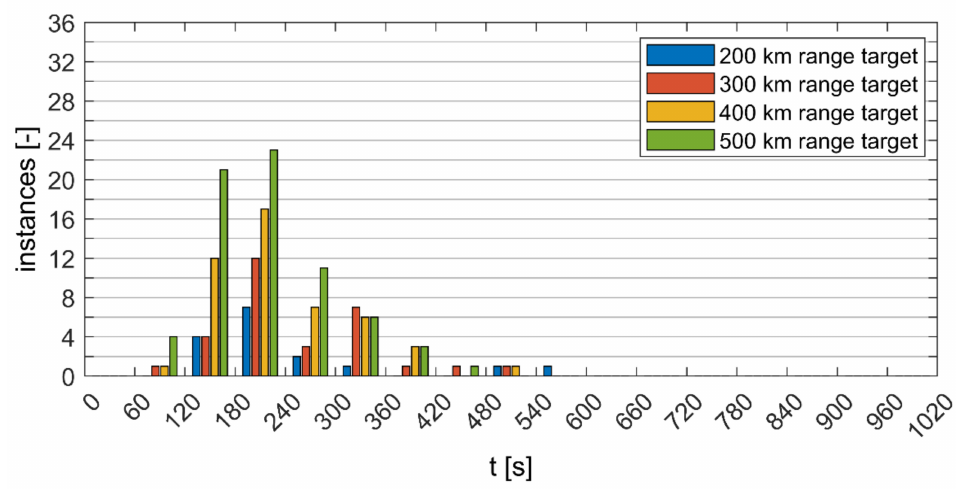
Figure A6. REX engagement instances binned by engagement time for CLTC-P and vehicle mass of 2100 kg.